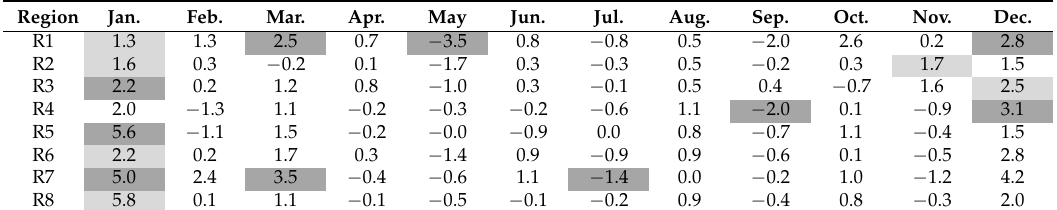
Table 4. Monthly rainfall trends (mm/month) of eight distinct climatic regions.